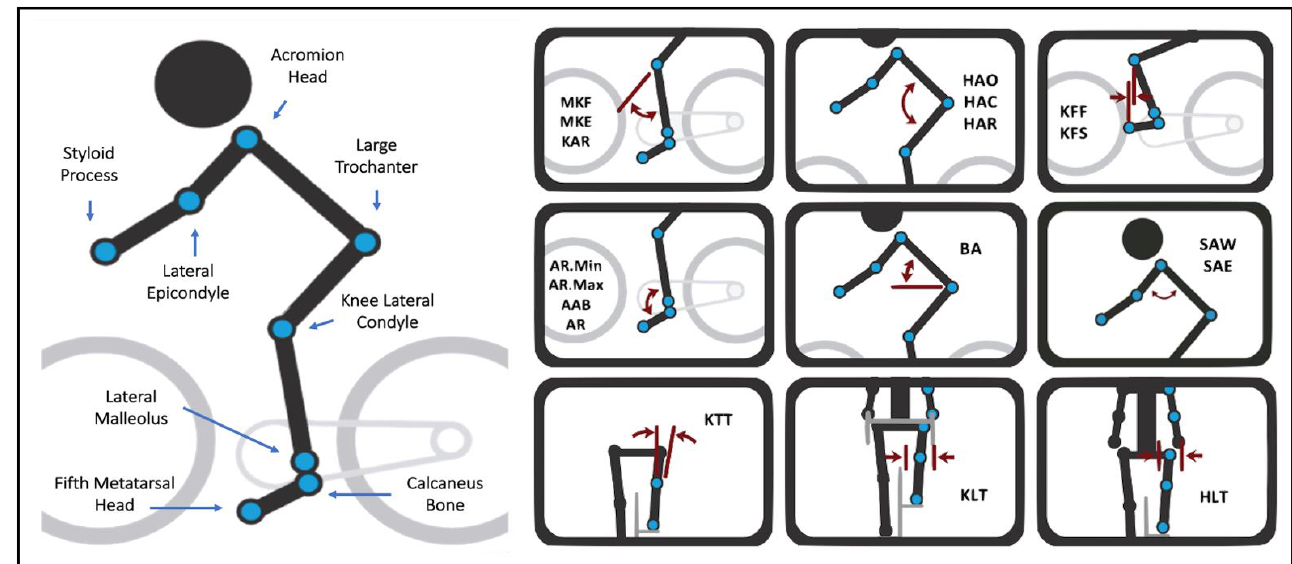
Figure 2. Schematic layout of all 3D kinematic measurements used with rider’s body markers location. Ankle minimum (AR.Min), ankle maximum (AR.Max), ankle range (AR), ankle angle at bottom (MB), maximum knee flexion (MKF), maximum knee extension (MKE), knee angle range (KAR), knee forward of foot (KFF), knee forward of spindle (KFS), knee travel tilt (KTT), knee lateral travel (KLT), hip angle closed (HAC), hip angle open (HAO), hip angle range (HAR), hip lateral travel (HLT), back angle (BA), shoulder angle to wrist (SAW), shoulder angle to elbow (SAE).